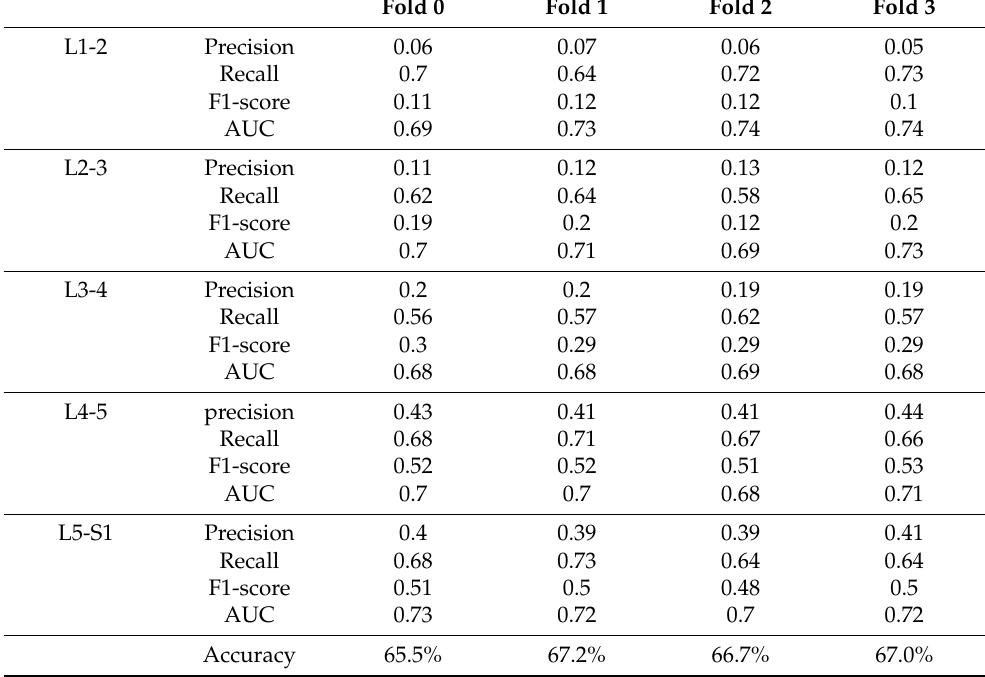
Table 3. Results for predicting the presence of HNP in each level of lumbar through four-fold